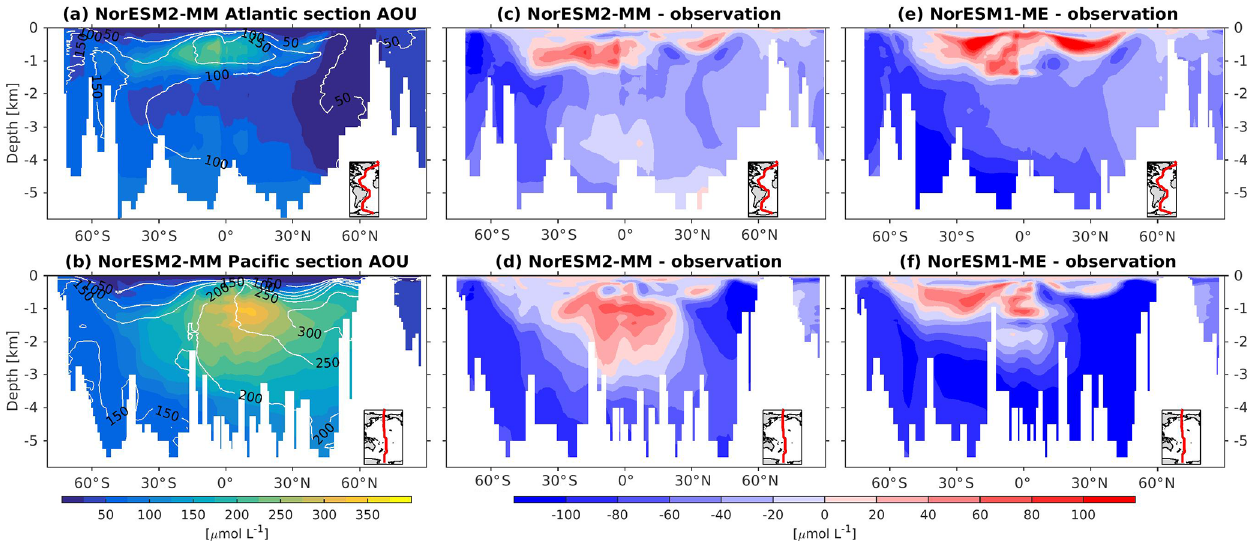
Figure 12. Climatology of apparent oxygen utilization (AOU) values across the vertical sections of (a) the Atlantic and (b) Pacific in NorESM2 (colour shadings) and from observations (contour lines). Differences between NorESM2-MM (or NorESM1-ME) and observations are shown in panels (c) – (f)